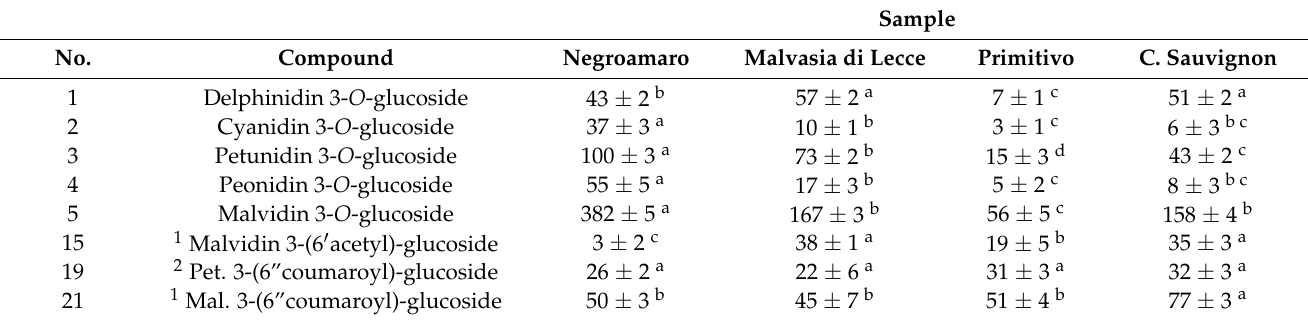
Table 3. HPLC/MS quantification of the main anthocyanin compounds in the grape marcs ( µ g/g DW).